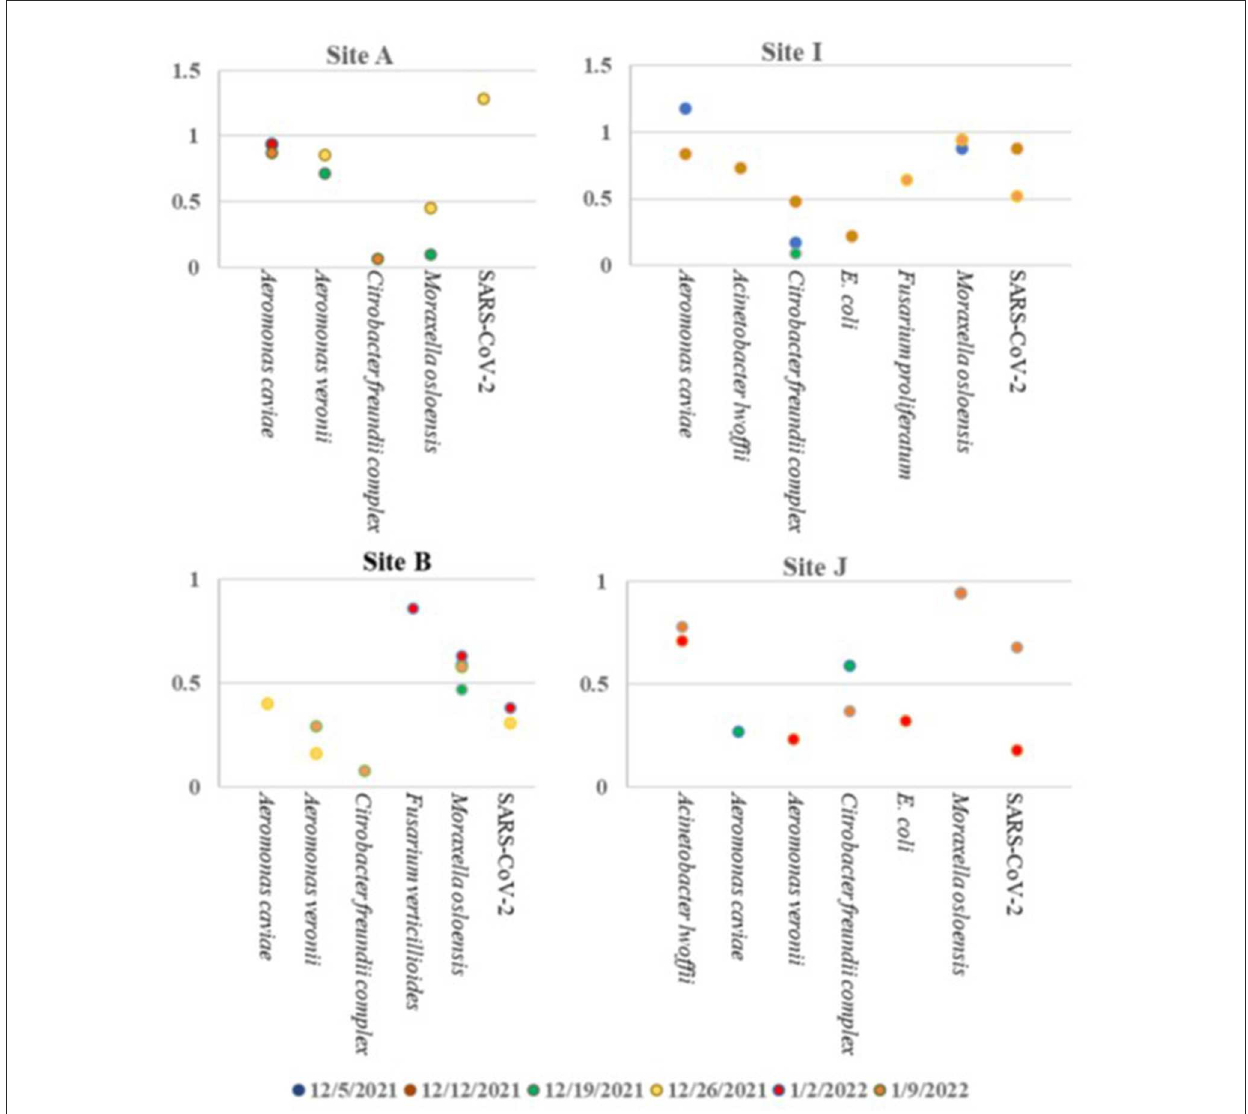
FIGURE6 Pathogens identified in sites A, B, I, and J over time using the Illumina Respiratory Pathogen and AMR Targeted Sequencing